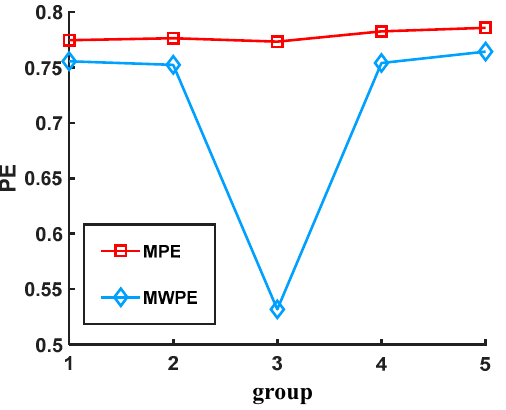
Figure 3. Permutation entropy results.